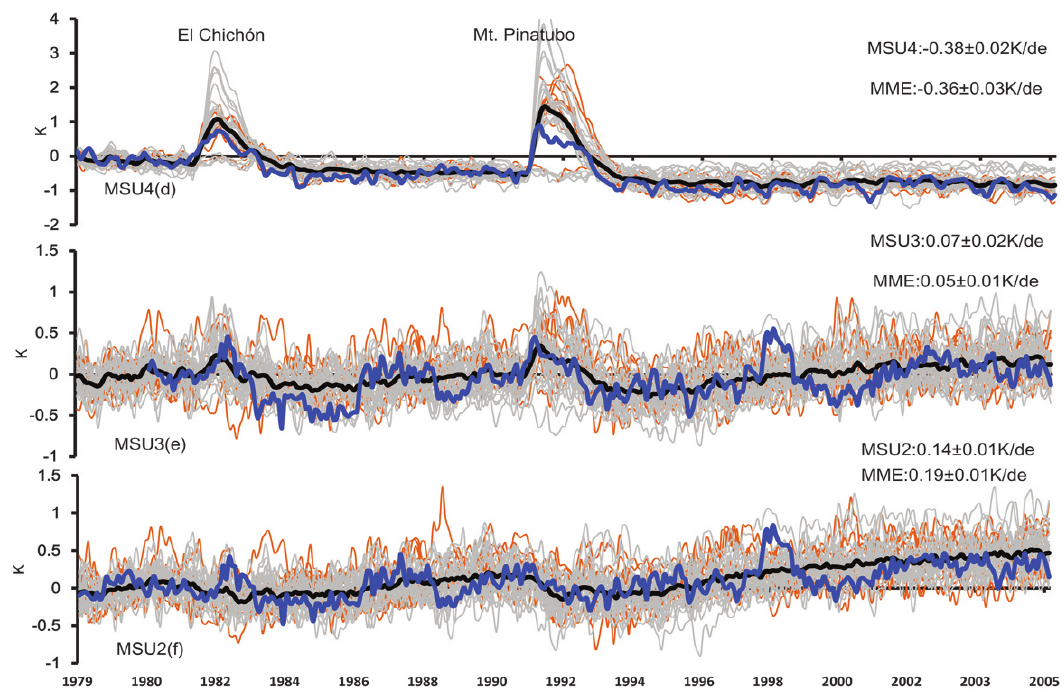
Figure 2. Global temperature anomalies time series (K) in the period of 1979–2005 at ( a ) SSU3, ( b ) SSU2; ( c ) SSU1. Note SSU1~SSU3 represent the SSU observational layers. Blue thick line represents the STAR observation. Gray and orange lines indicate the low-top and high-top CMIP5 model, respectively, Black thick line represents model ensemble mean. Figure 2b is the same as Figure 2a except for the MSU observation ( d ) MSU4; ( e ) MSU3; ( f ) MSU2. Note MSU2-MSU4 represents the MSU observational layers. MME is multiple model ensemble mean.